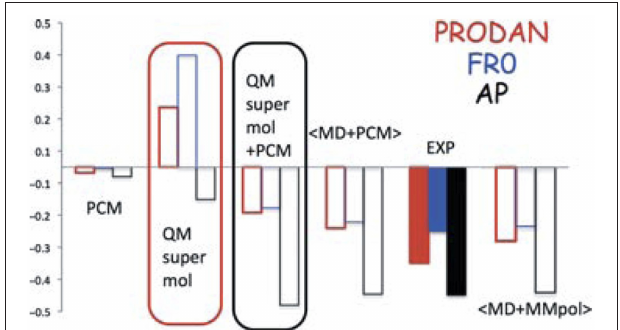
FIGURE 14 | TDCAMB3LYP/6-311 + G(d,p)/PCM results of shifts (in eV) of the emission energies of AP, PRODAN, and FR0 moving from a polar (acetonitrile for AP and dimethylsulfoxide for PRODAN and FR0) to a protic polar (water for AP and PRODAN, methanol for FR0) solvent. Reproduced with permission from Mennucci (2012). Copyright 2012, John Wiley & Sons,